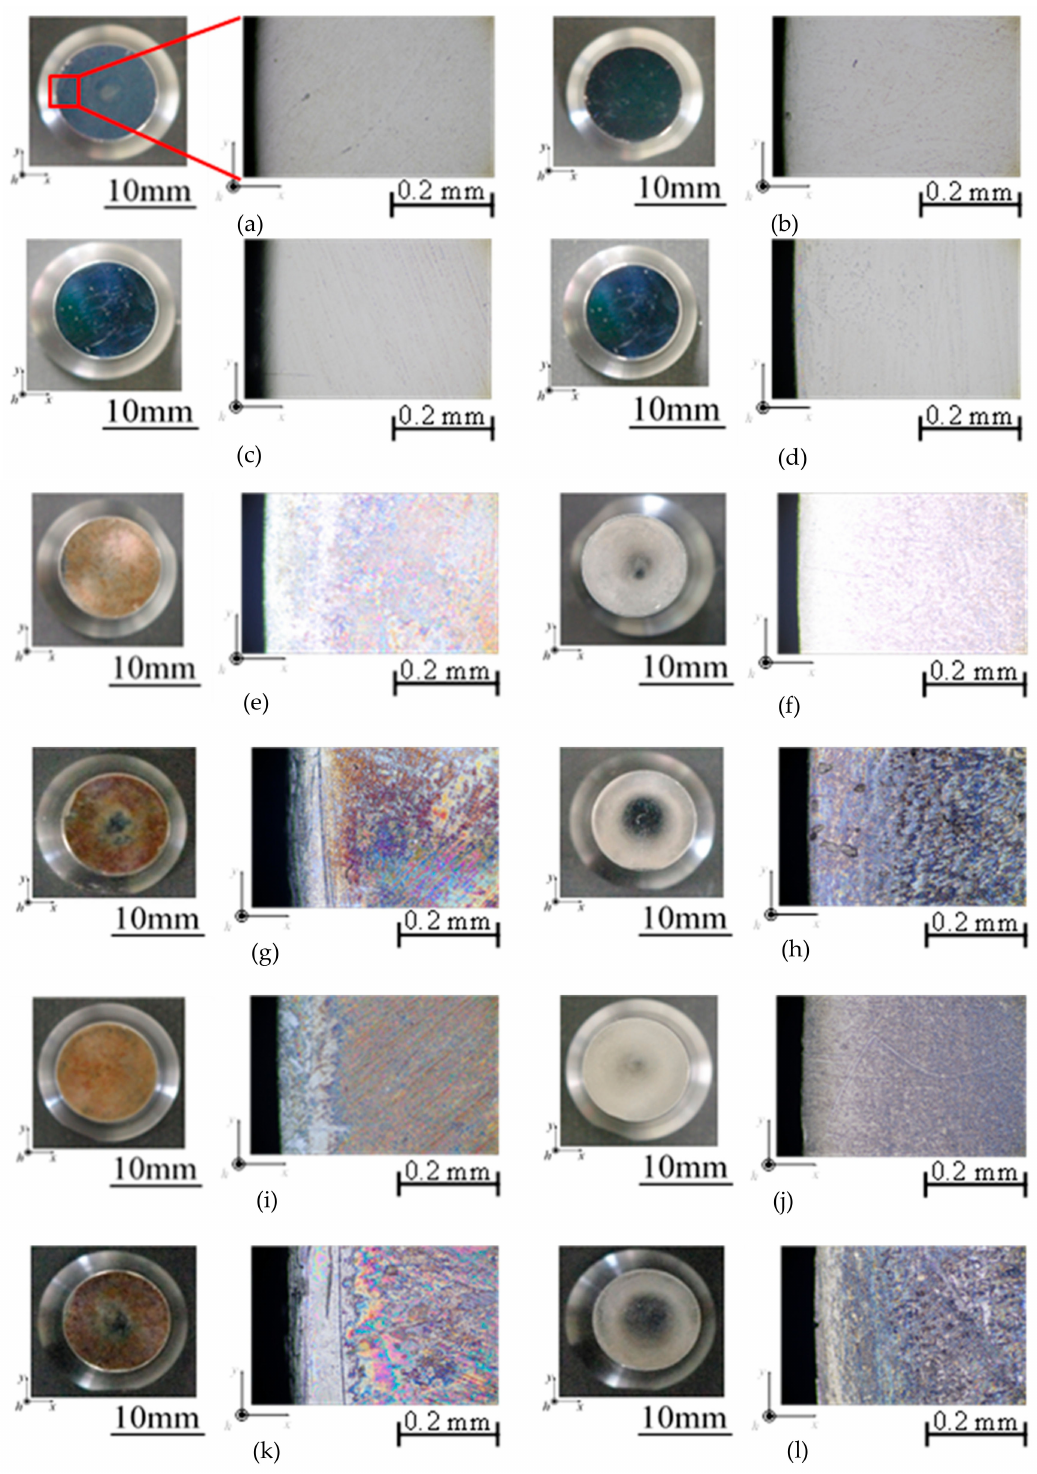
Figure 5. Working surface conditions. (Left—full image, Right—magnified image): ( a ) 150 kN (WOL)—Initial; ( b ) 150 kN (WL)—Initial; ( c ) 180 kN (WOL)—Initial; ( d ) 180 kN (WL)—Initial; ( e ) 150 kN (WOL)—7000 cycles; ( f ) 150 kN (WL)—7000 cycles; ( g ) 180 kN (WOL)—7000 cycles; ( h ) 180 kN (WL)—7000 cycles; ( i ) 1150 kN (WOL)—14,000 cycles; ( j ) 150 kN (WL)—14,000 cycles; ( k ) 180 kN (WOL)—14,000 cycles; and, ( l ) 180 kN (WL)—14,000 cycles. (WL—With Lubrication, WOL—Without